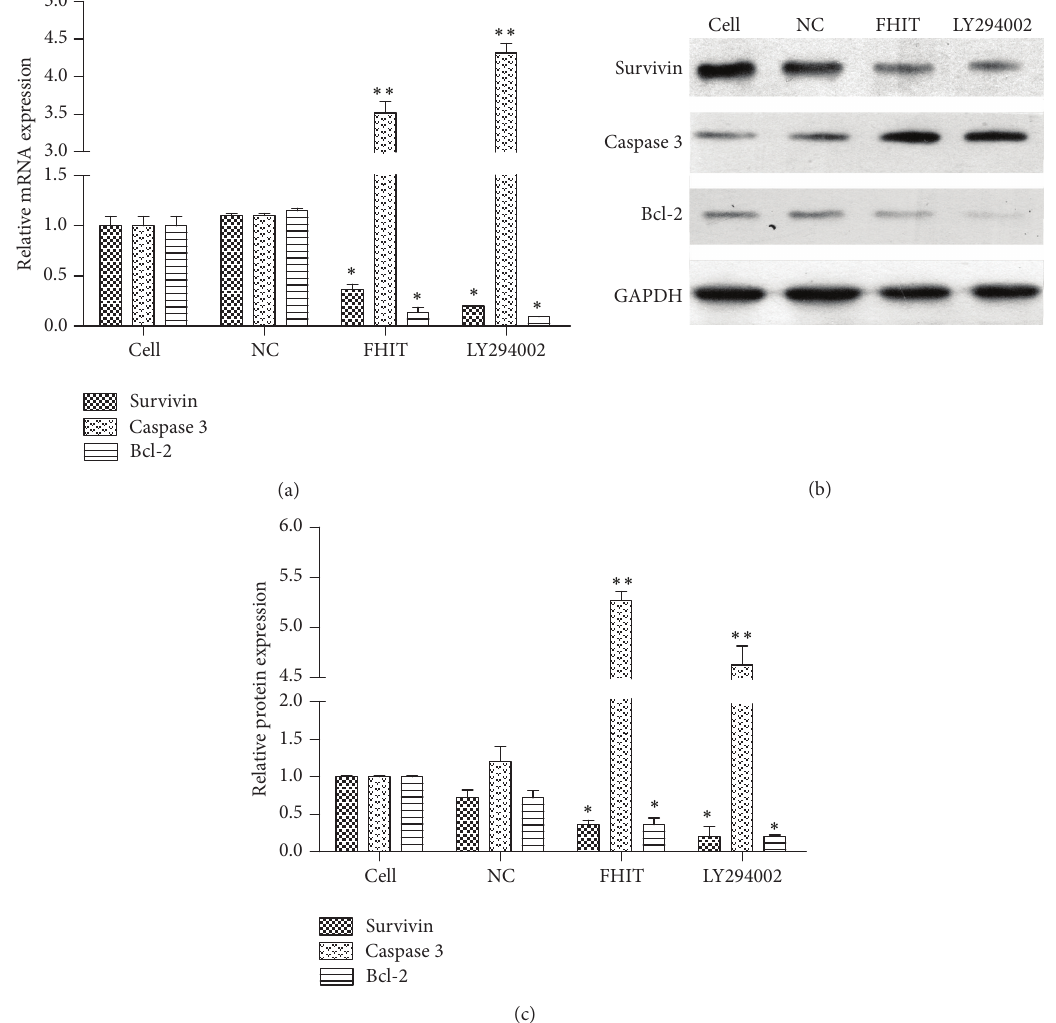
Figure 3: The expression of survivin, Bcl-2, and caspase-3 in QBC939 cells in each group after transfection or treatment with LY294002. (a) The mRNA expression of survivin , Bcl-2 , and caspase-3 in each group, as assessed by RT-PCR. (b) Western blotting for survivin, Bcl-2, and caspase-3. (c) Quantification of the expression levels of survivin, Bcl-2, and caspase-3 in each group, presented in bar graphs as fold-increase. ∗ 𝑃 < 0.05 , ∗∗ 𝑃 < 0.01